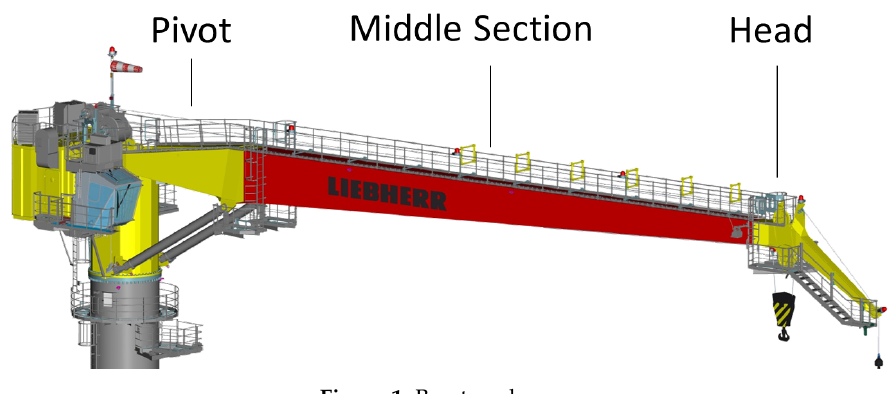
Figure 1. Box-type